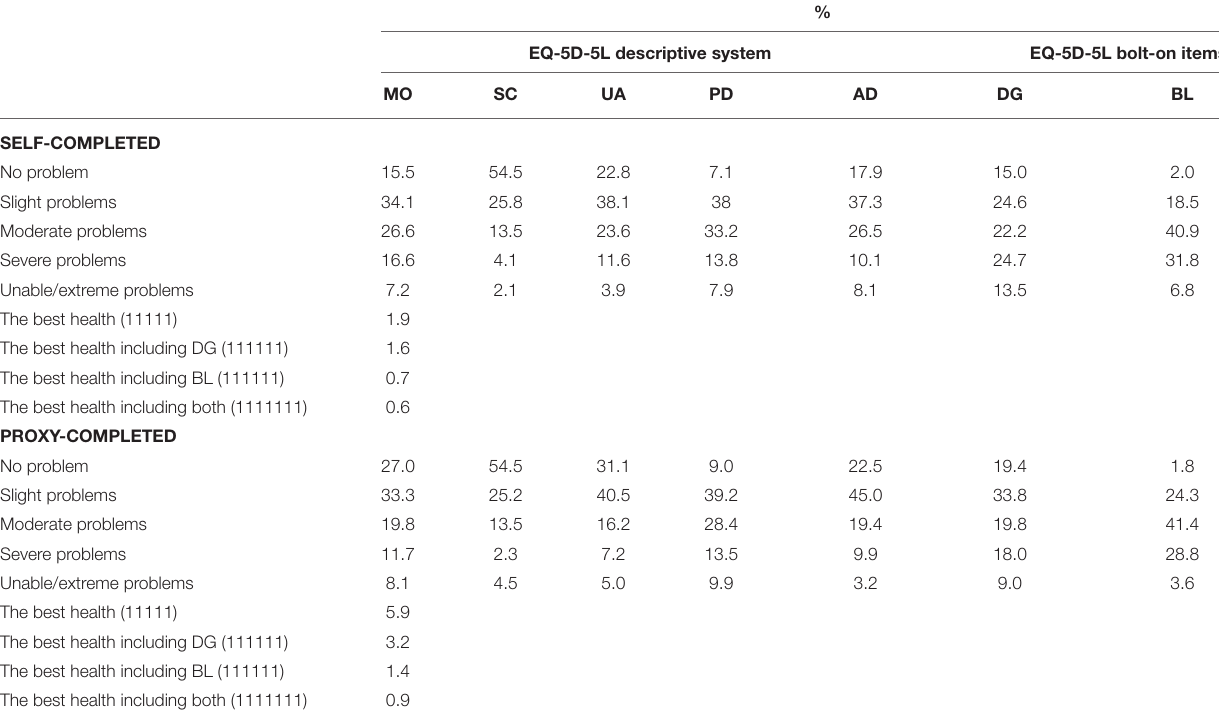
TABLE 2 | Proportion of EQ-5D-5L items and the two bolt-on items.